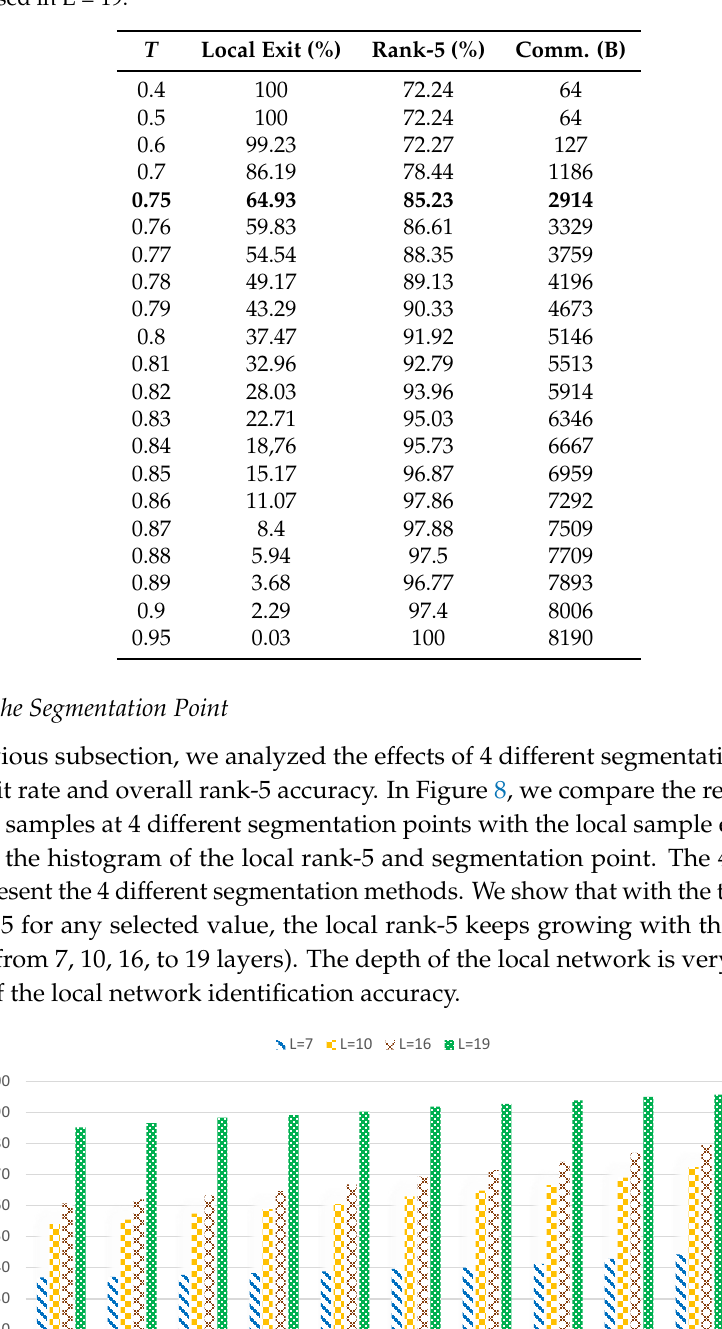
Table 5. While local network L = 19, the effects of different exit thresholds ( T ) settings for the local. T = 0.75 is used in L = 19.